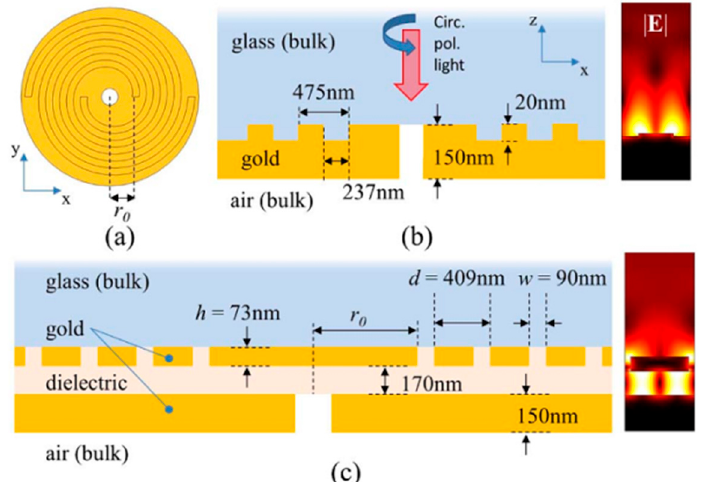
Figure 19. ( a ) Top view and ( b ) cross-section of a single-layer holey plasmonic vortex lens (PVL); ( c ) schematic diagram of the designed holey PVL. The CPL impinges from the glass side with the wavelength of 780 nm. Inserts in ( b , c ) are the electric field profiles of the plasmonic modes excited by CPL of two PVLs structures. Reproduced with permission from [64]. Copyright Optical Society of America, 2014.